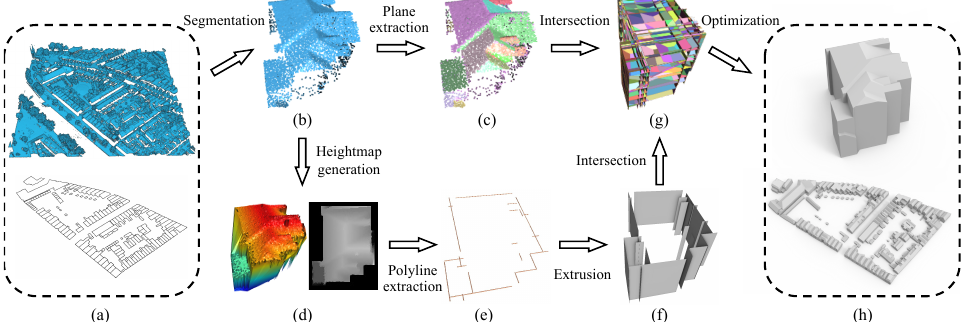
Figure 2. The pipeline of the proposed method (only one building is selected to illustrate the workflow). ( a ) Input point cloud and corresponding footprint data. ( b ) A building extracted from the input point cloud using its footprint polygon. ( c ) Planar segments extracted from the point cloud. ( d ) The heightmap (right) generated from the TIN (left, colored as a height field). ( e ) The polylines extracted from the heightmap. ( f ) The vertical planes obtained by extruding the inferred polylines. ( g ) The hypothesized building faces generated using both the extracted planes and inferred vertical planes. ( h ) The final model obtained through